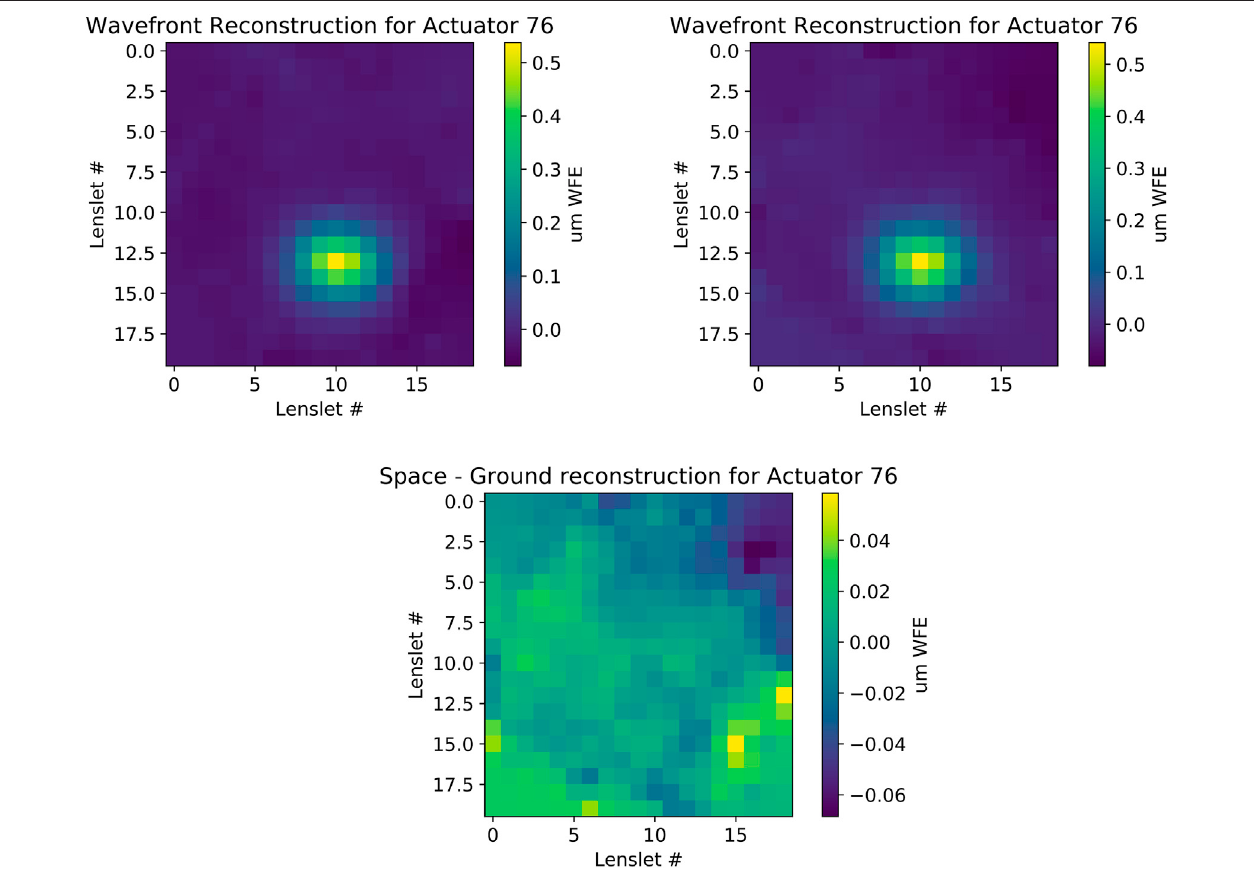
FIGURE 3 | Top left: reconstructed SHWFS measurement of single actuator poke on the ground prior to launch. Top right: reconstruction of the same actuator pokedinspace.Bothtestswererecordedusingall fl ighthardwareandtheinternallaserdiodesource.SeeMorganetal.(2021)fordetailsoftheinstrumentcalibrationon the ground and in orbit. Bottom: the residual difference in reconstructed wavefront between the space and ground measurements.